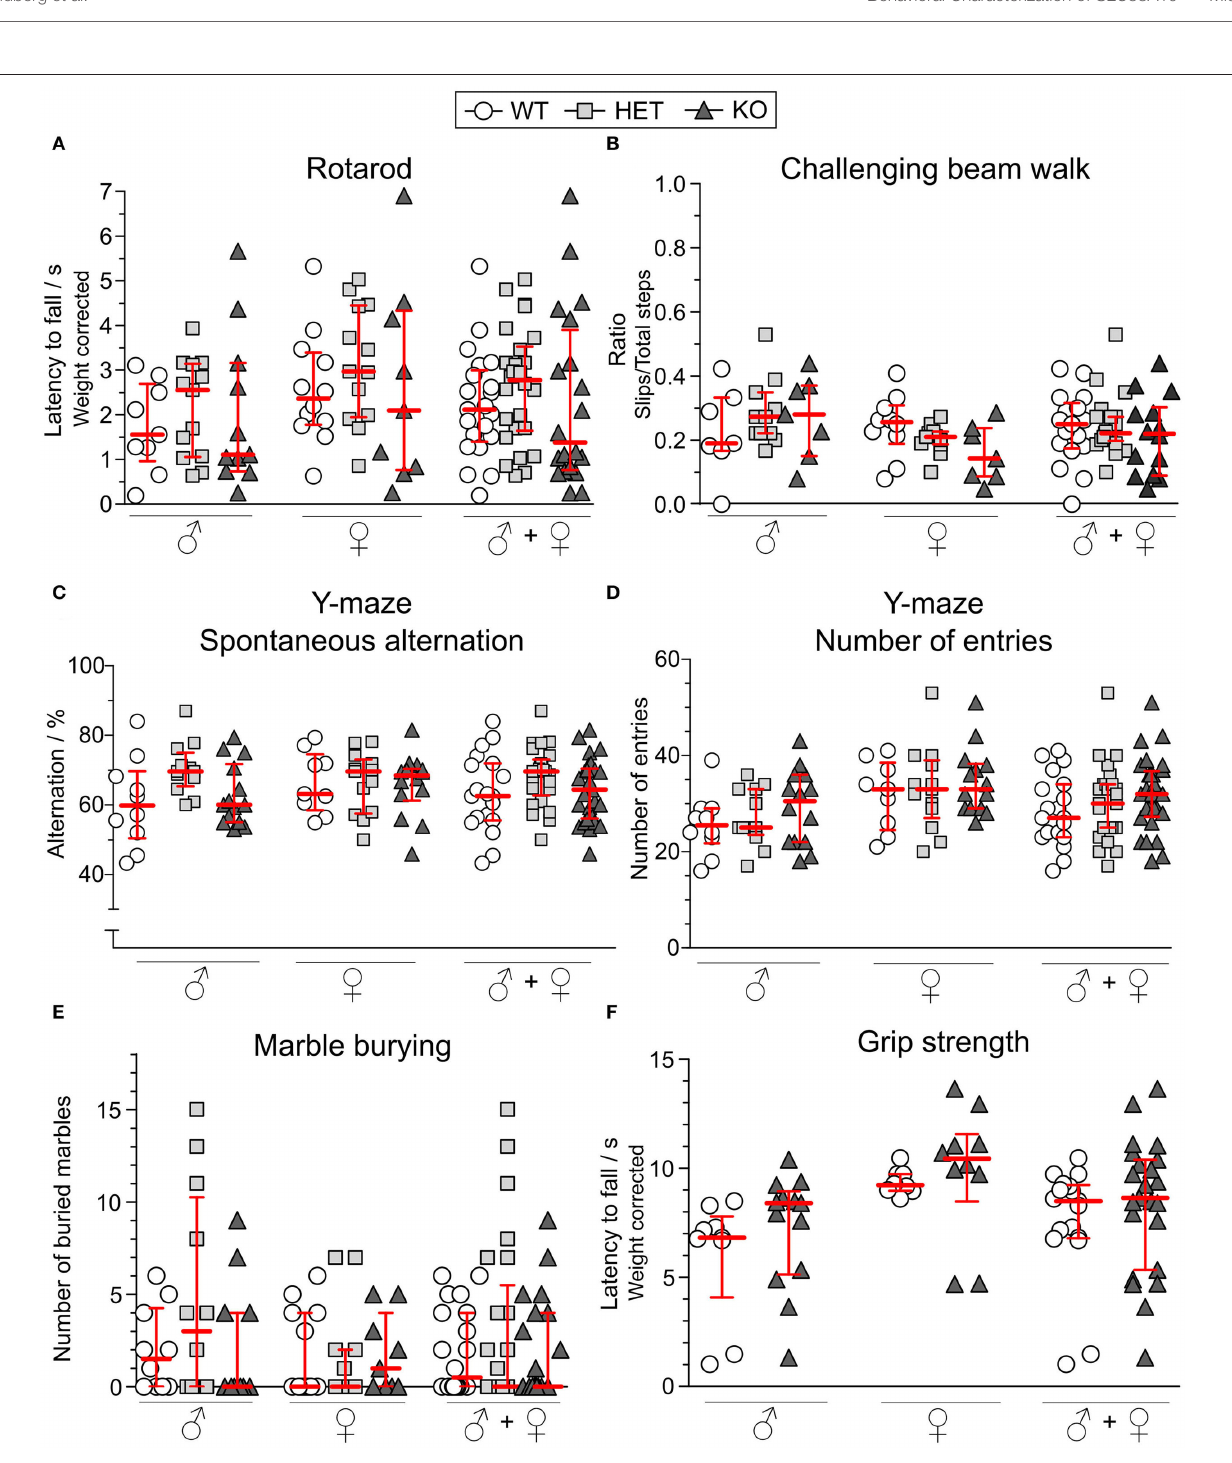
Frontiers in Behavioral Neuroscience |